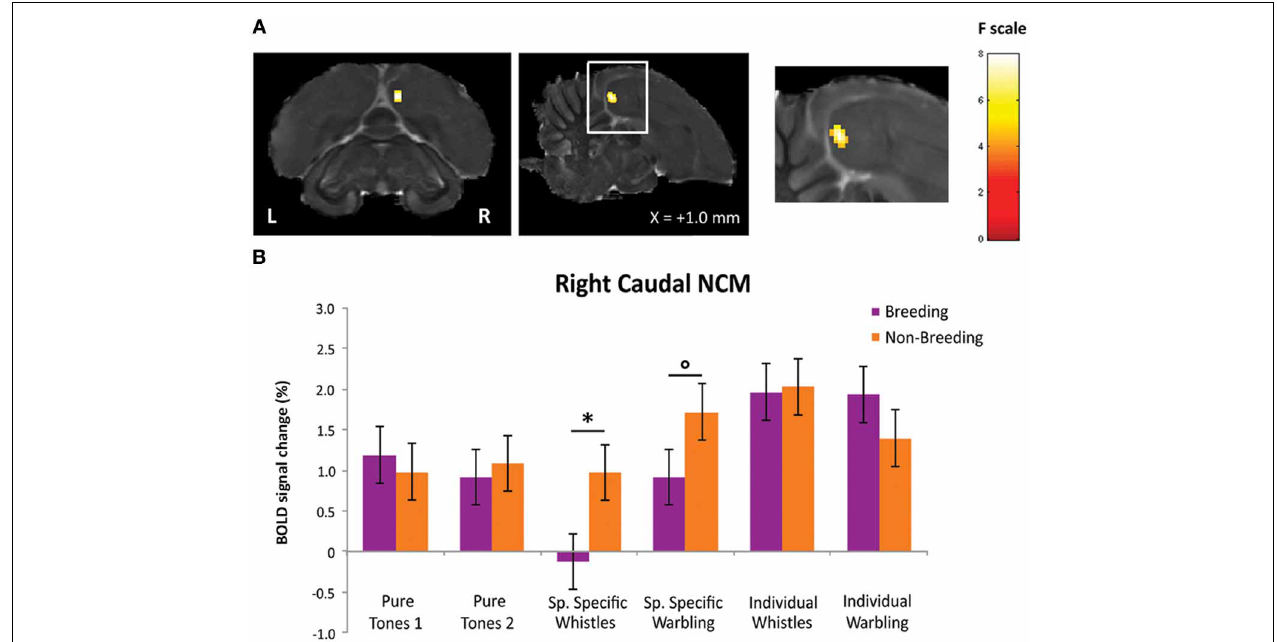
FIGURE 5 | Effect of season on differential song processing. (A) Statistical map of voxels displaying a significant difference in differential song processing between breeding and non-breeding season [(INDIV—PT) vs. (SPECT—PT)] breeding vs. [(INDIV—PT) vs. (SPECT—PT)] non − breeding ( F -test from a repeated measures ANOVA; N = 5). F -values are color coded according to the scale displayed on the right. The position of the slice along the X (left/right) axis is indicated (the + sign indicates that results are from